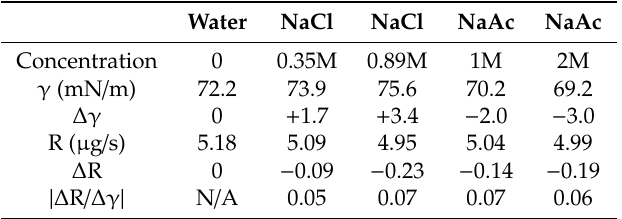
Table 2. Comparison of surface tension and evaporation rate of sodium